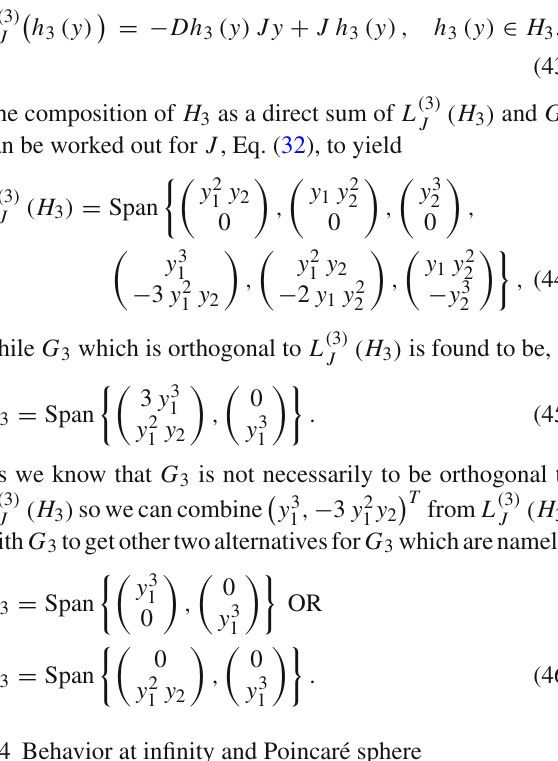
representation that provides a global picture of the solu- tion curves’ behavior, specially at infinity. This global pic- ture can be achieved by introducing the so-called Poincaré sphere [32,33] where one projects from the center of the unit (cid:26) (cid:27) ( X , Y , Z ) ∈ R 3 | X 2 + Y 2 + Z 2 = 1 onto sphere S 2 = the ( x 1 , x 2 ) -plane tangent to S 2 at either north or south pole as shown in Fig. 3. Projecting the upper hemisphere of S 2